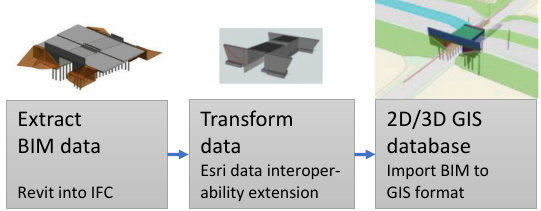
Figure 7. Example of a bridge structure migrated from BIM into GIS data (Schaller et al., 2017).